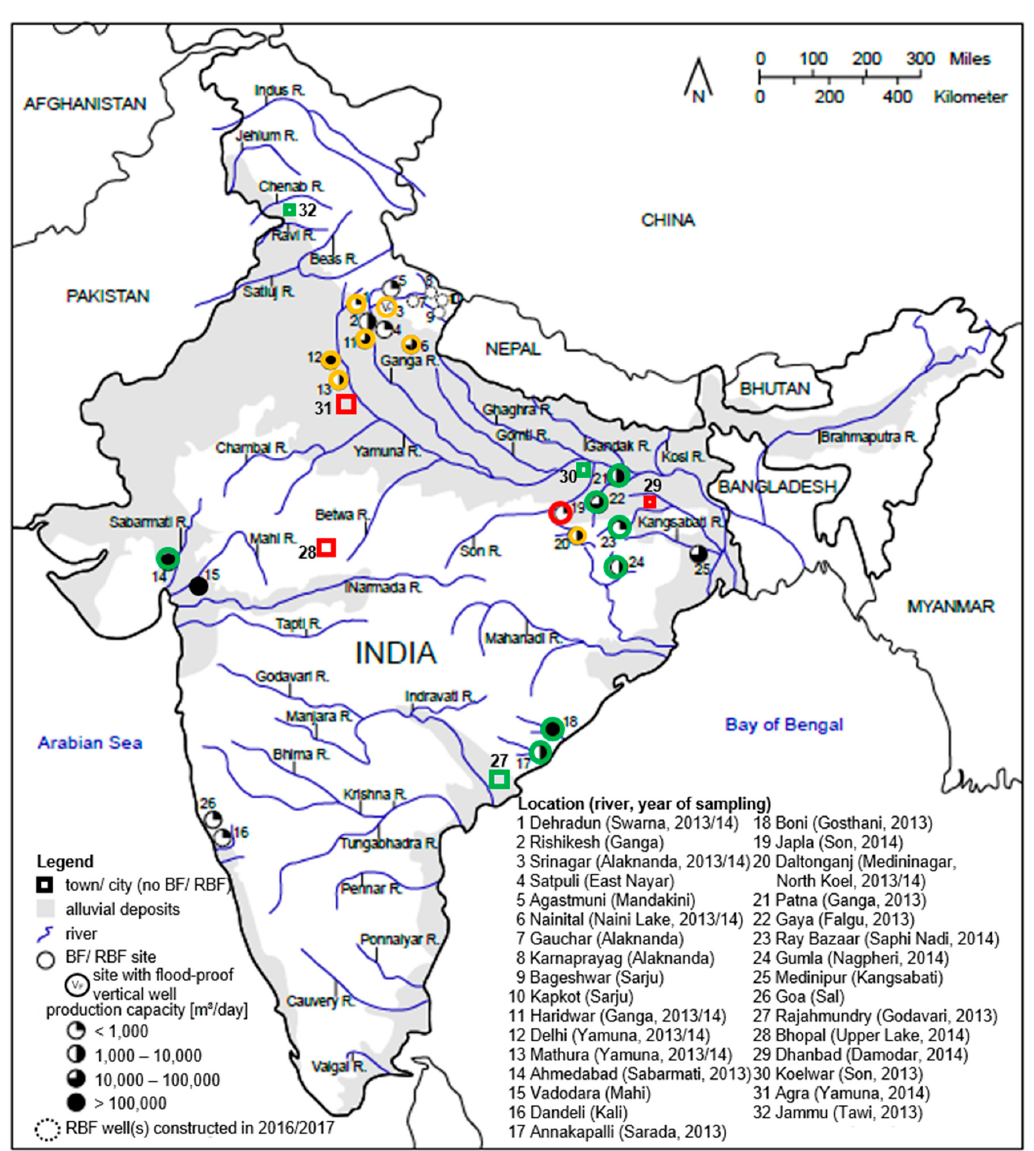
Figure 1. Locations having riverbank filtration (RBF) wells in India and those sampled in 2013 (monsoon, green circles), 2014 (non-monsoon, red circles), and both in 2013 and 2014 (orange circles), including six locations where it was not conclusively established that the existing wells abstract bank filtrate (squares) (modified from [22]).